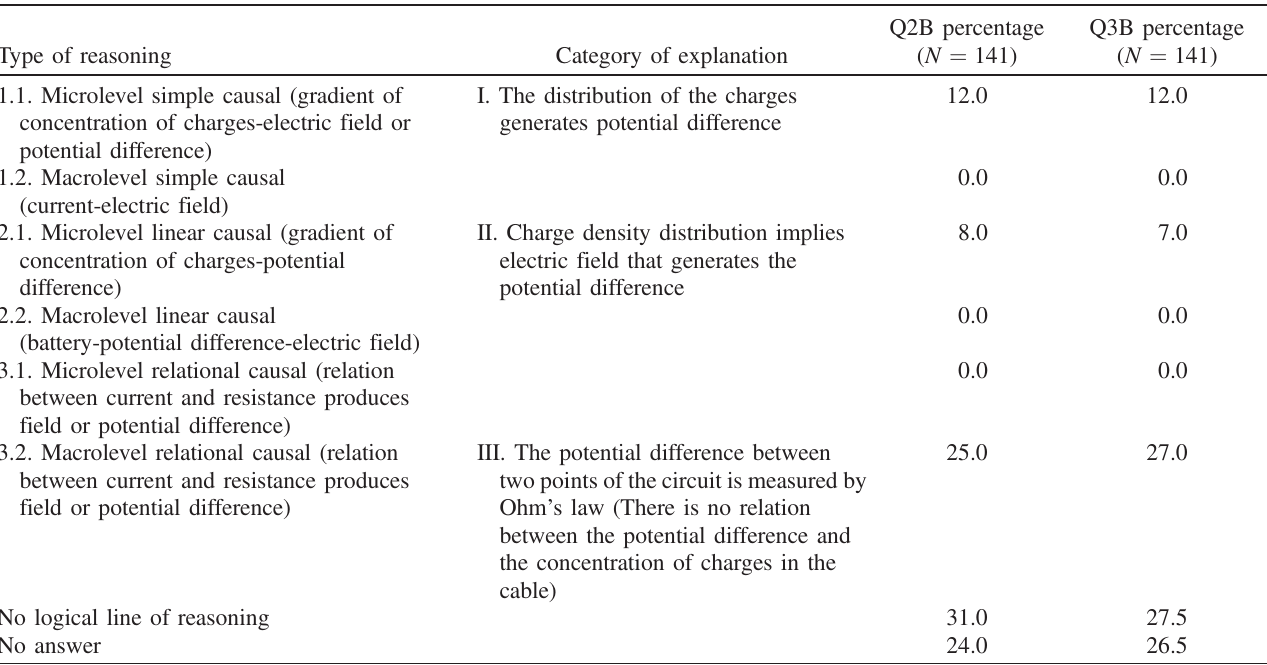
TABLE III. Categories of explanation to the definition of potential difference in Q3B and its relation to charges distributions in Q2B. Type of